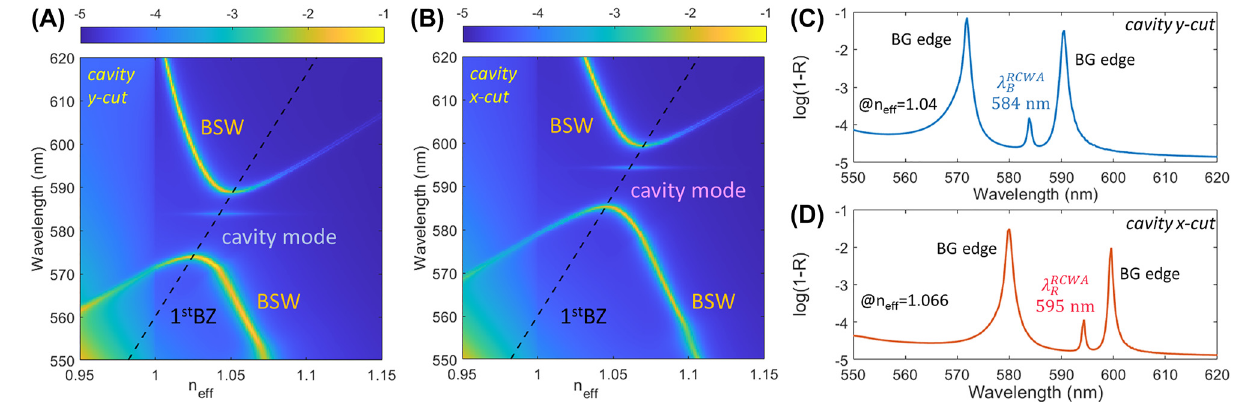
Figure 5: RCWA model of the cavity. Calculated angularly-resolved spectral maps log(1 − R ) related to the cross-sectional cuts of the cavity along (A) the y -direction and (B) the x -direction. Calculations are performed assuming a TE-polarization, i.e. x -polarized in (A) and y -polarized in (B); black dashed line: boundary of the 1st Brillouin zone introduced by the DBR. The cavity modes are located in the BSW bandgap, as indicated; (C) and (D) = 1.04 and for the x -cut at n = 1.066, linear plots of log(1 − R ) for the y -cut at n eff eff